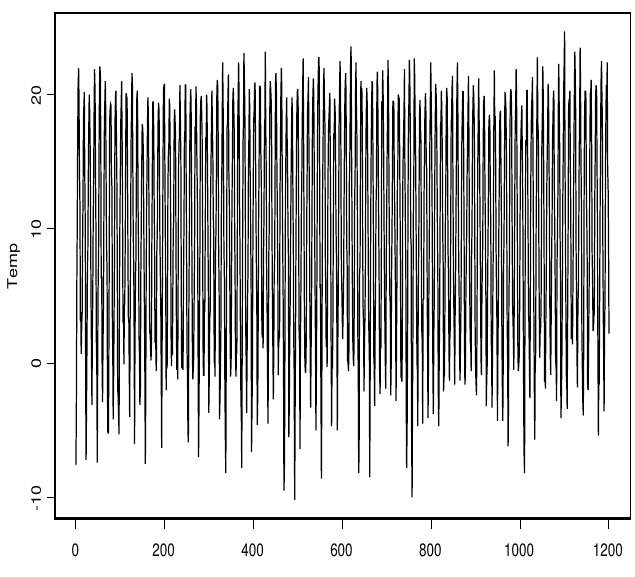
Figure 1. Monthly mean temperature.